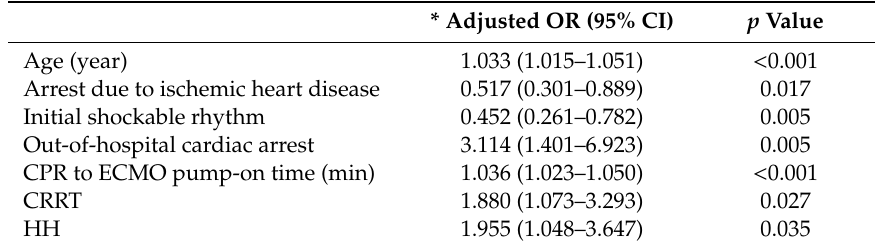
Table 3. Factors Associated with In-hospital Mortality after